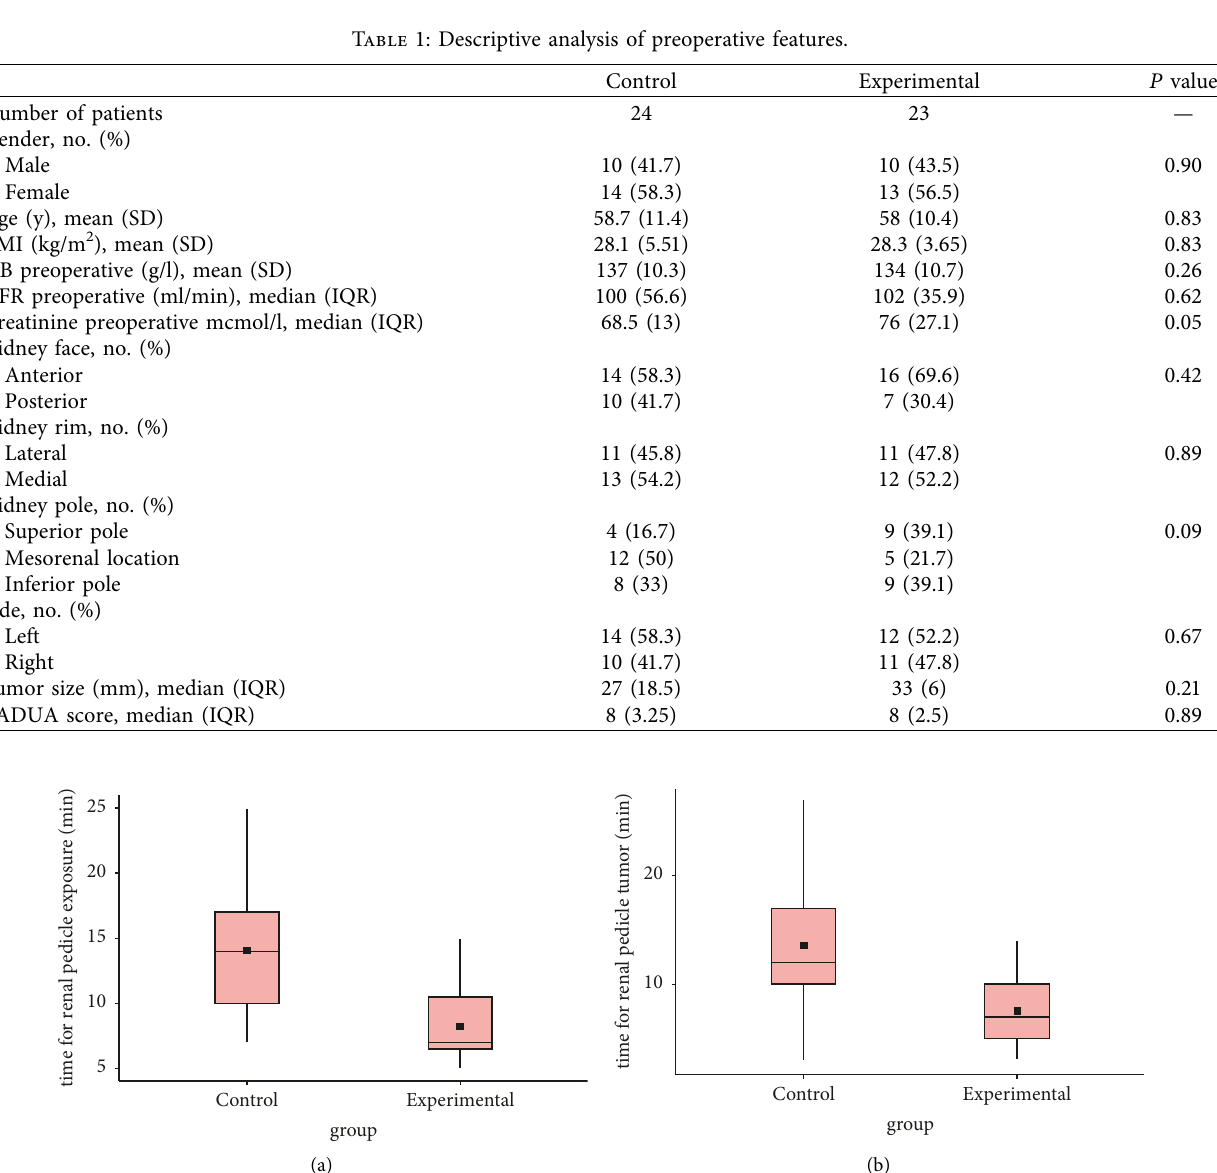
Figure 4: Time parameters for renal pedicle exposure (a) and for tumor location determination